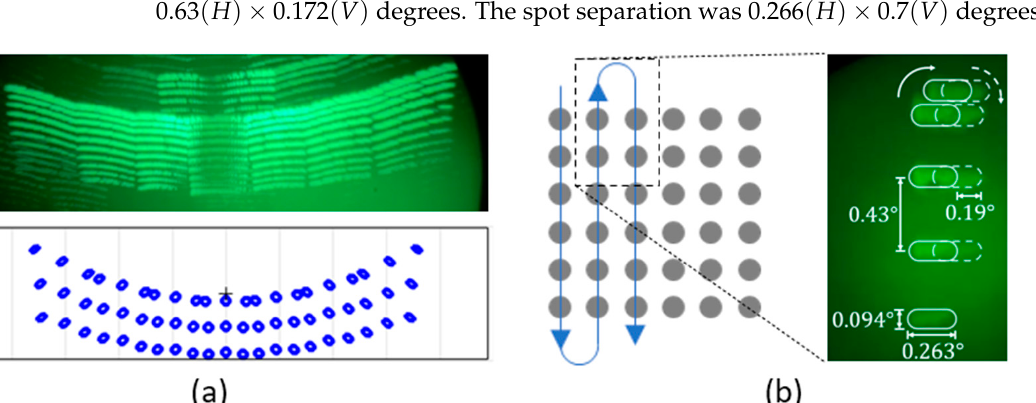
Figure 7. ( a ) A long exposure of the scanning pattern captured by an IR viewer (top), and simulated scanning pattern (bottom). ( b ) Beam scanning pattern at the top edge of the sub-FOV with beam divergence values. The “+” indicates the center of 0 th order sub-FOV.